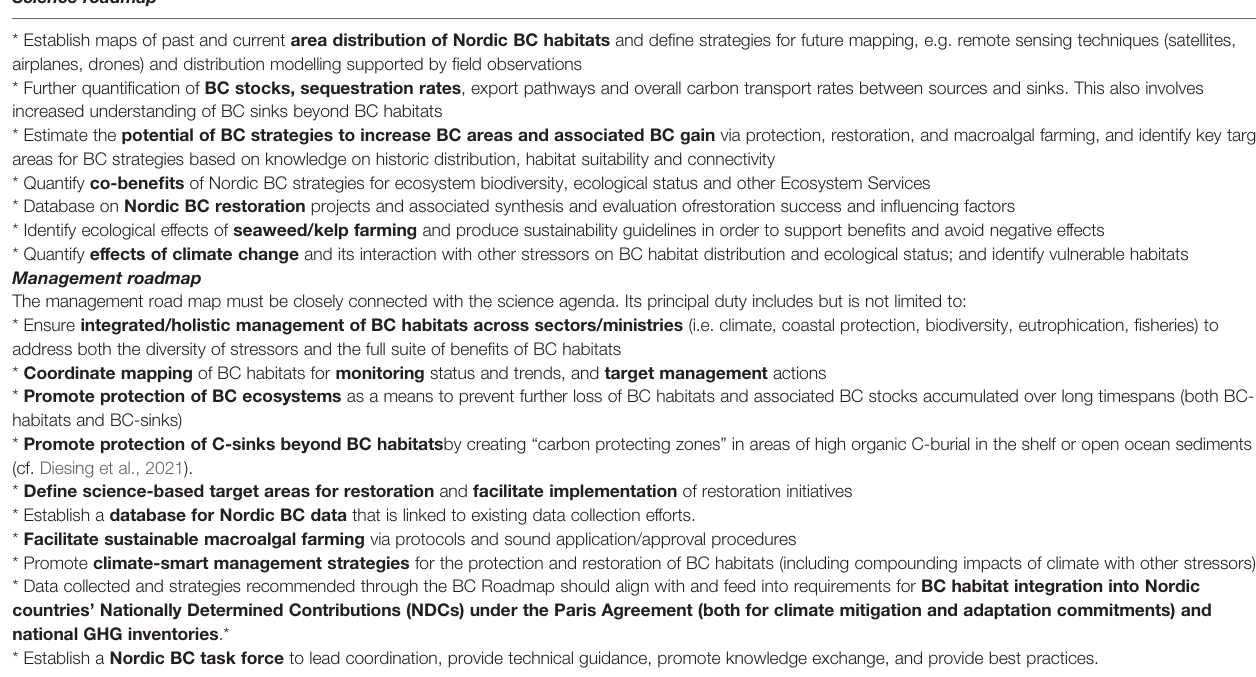
TABLE 4 | Proposed Nordic science and management roadmap for Blue Carbon. Science